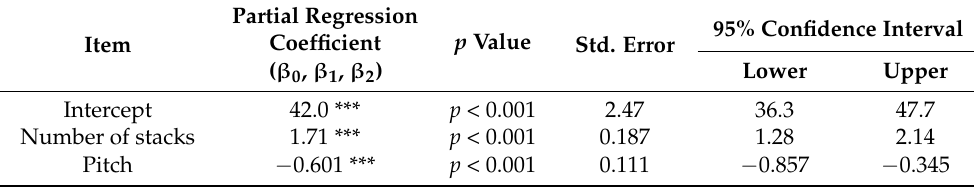
Table 5. Multiple regression analysis results using progressive crushing mode results